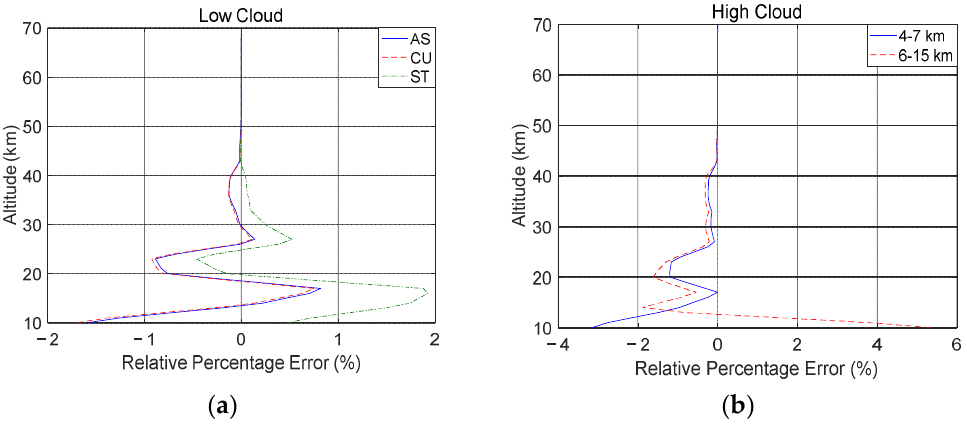
Figure 8. Relative errors between cloud and no cloud cover. ( a ) Low cloud coverage; ( b ) high clouds.